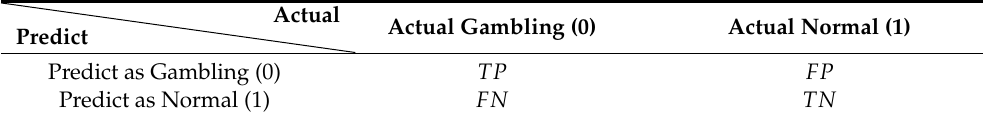
Table 1. The confusion